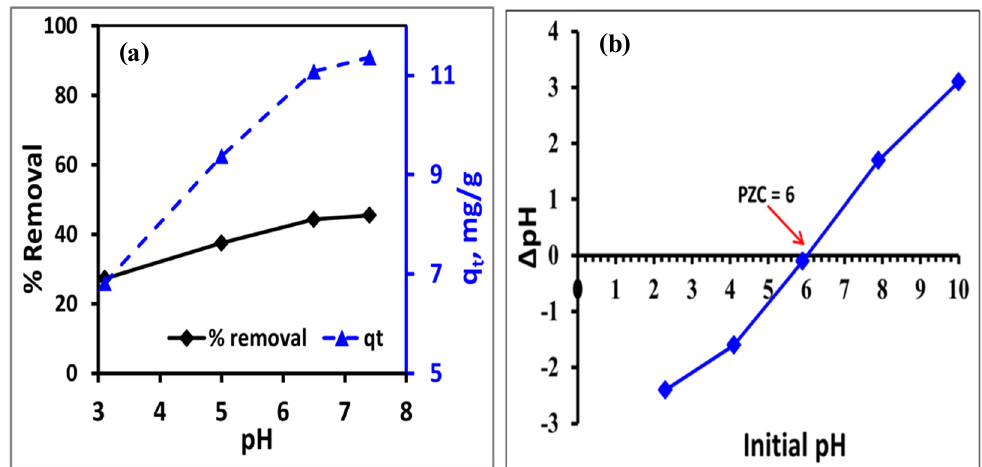
Figure 4. ( a ) Effect of pH on adsorption of Co 2+ by ZrO 2 NPs (ZrO 2 mass: 0.3 g, vol: 50 mL, Co 2+ conc: 150 ppm, time: 30 min, Temp.: 25 °C) and ( b ) The point of zero charge of ZrO 2 NPs570.